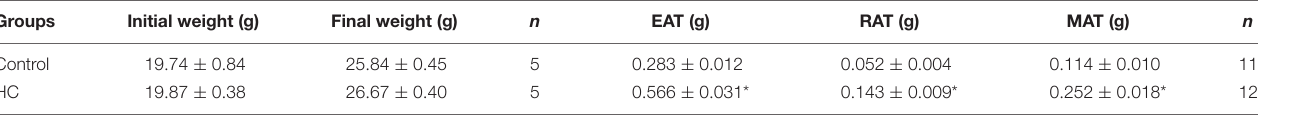
TABLE 1 | Body weight and epididymal (EAT), retroperitoneal (RAT), and mesenteric (MAT) adipose tissues values of control and HC groups. Groups Initial weight (g) Final weight (g) n EAT (g) RAT (g) MAT (g) n Control 19 . 74 ± 0 . 84